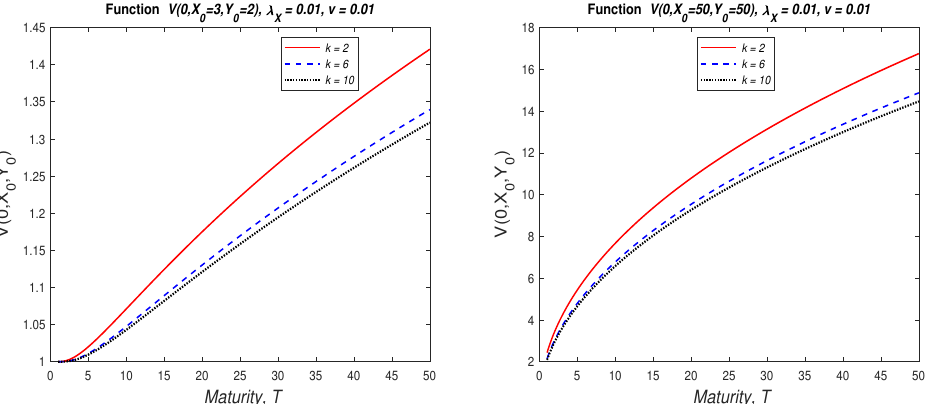
Figure 3. Dependence of value of the option V ( 0, X 0 , Y 0 ) according to Equation (32) on maturity T for X 0 = 3, Y 0 = 2 ( left ) and X 0 = 50, Y 0 = 50 ( right ).